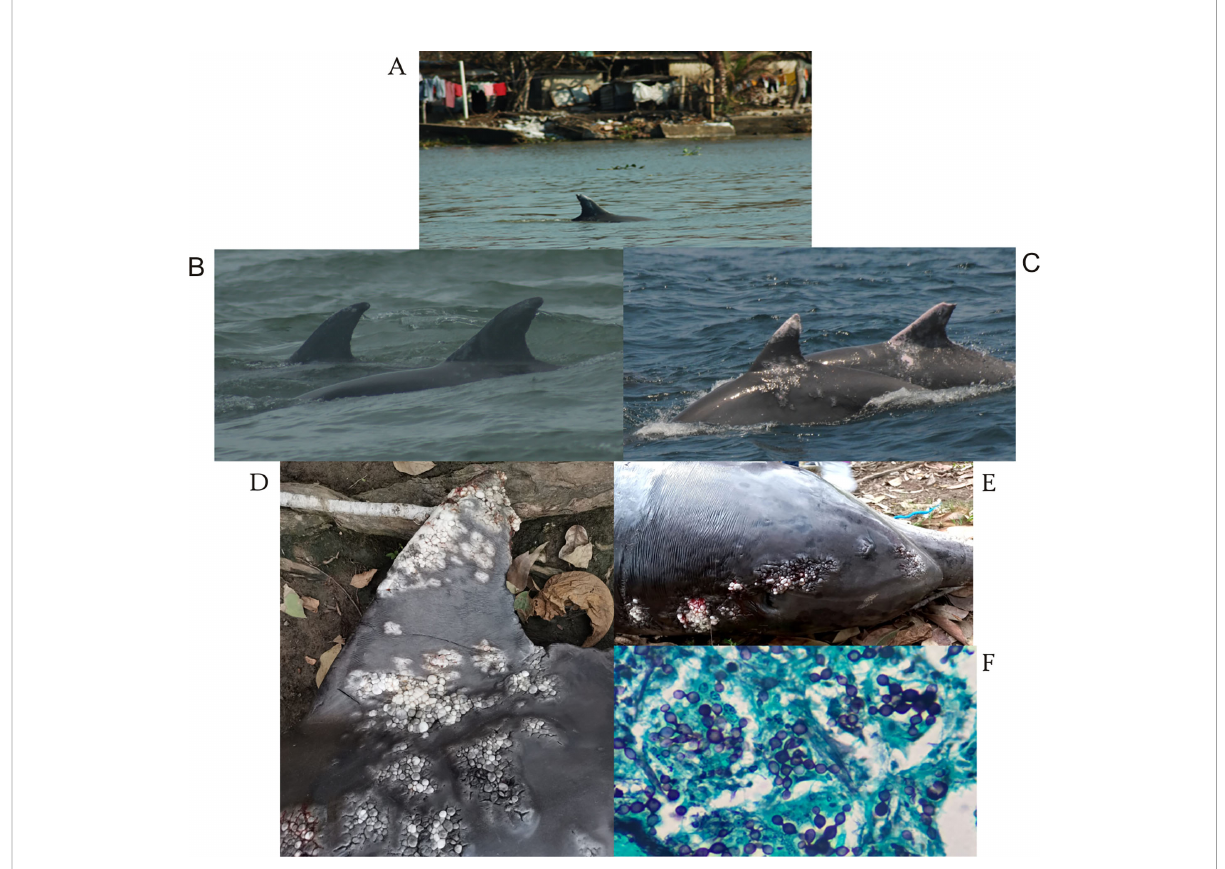
FIGURE 2 Wild-bottlenose dolphins from Alvarado affected by LLD. (A) Presence of individual EN05 at Alvarado lagoon close to rural communities exhibiting skin gross lesion possible related to LLD (2006), (B) pair of males, EN10 (right) and TN15 (left) with early LLD gross lesions in dorsal fi ns and dorsum (2006), (C) re-sighting of individual EN10 (left) and TN15 (right) with progression of skin lesions in dorsal fi ns and lateral fl anks (2019), (D) dorsal fi n of individual EN10 stranded at Papaloapan River with severe skin gross lesions, (E) multiple nodules ulcerated in head, anterior dorsum near to blowhole and lateral fl ank (left), (F) Microscopic image of dermal tissue of individual EN10. Note presence of rounded deep purple structures connected by a tube-shaped forms, typical of fungus Lacazia loboi . Methenamine Silver stain. Magni fi cation, 100x.